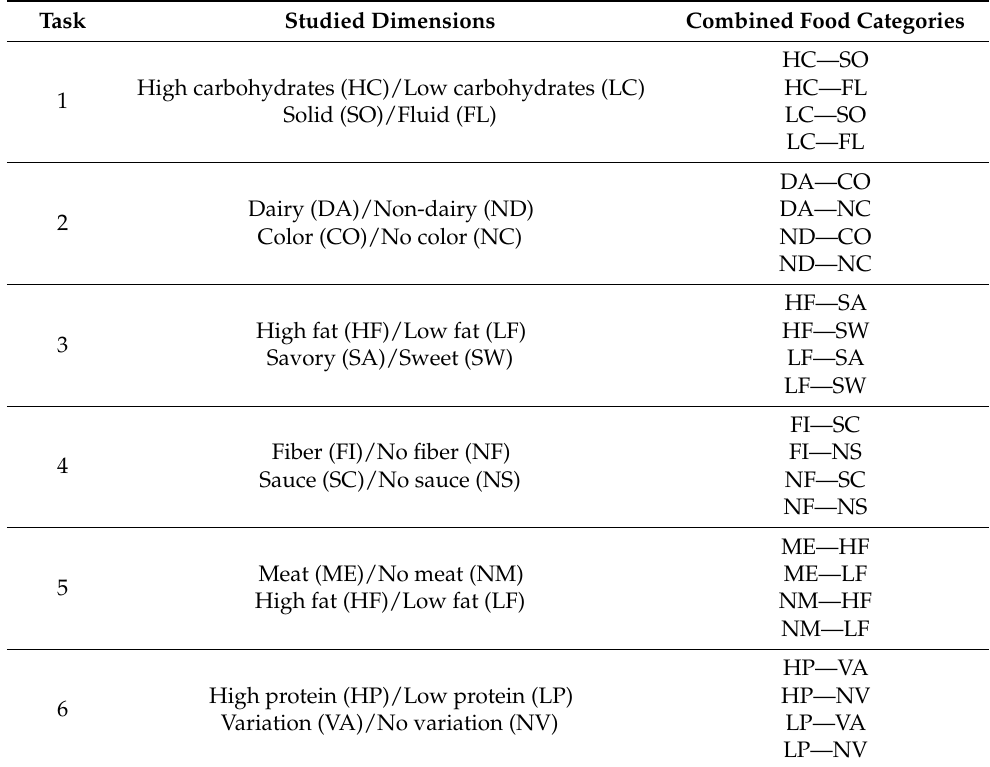
Table 1. Dichotomous food categories tested with the Leeds Food Preference questionnaire. Task Studied